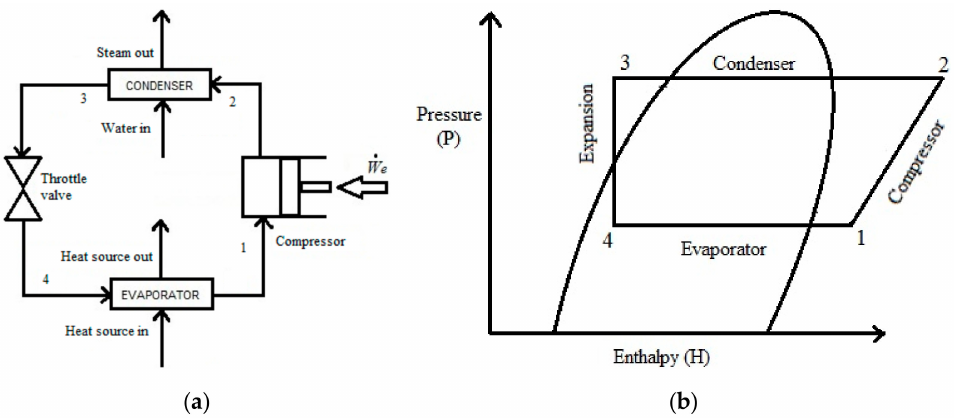
Figure 2. ( a ) Schematic of MVC heat-pump system. ( b ) Pressure–enthalpy diagram for cycle in ( a